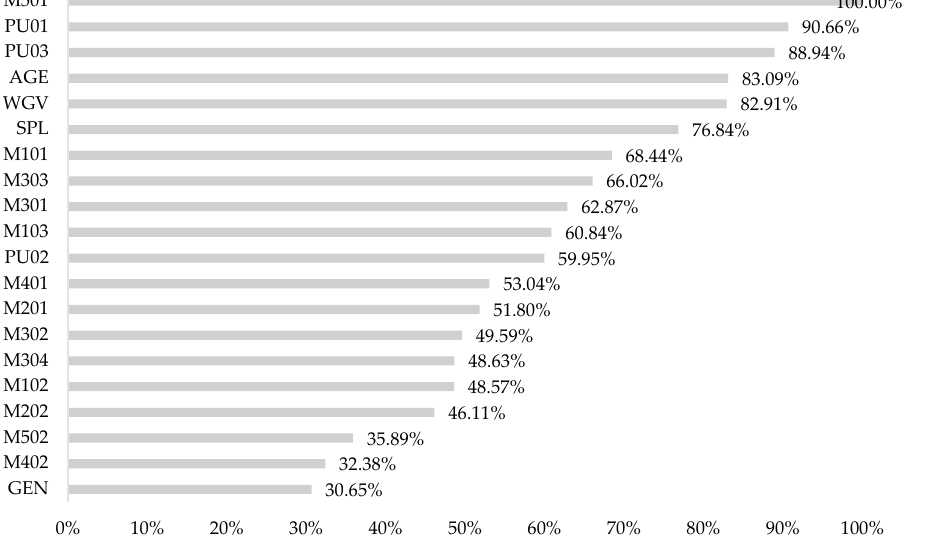
Figure 4. Normalised importance of independent variables in the ANN model.